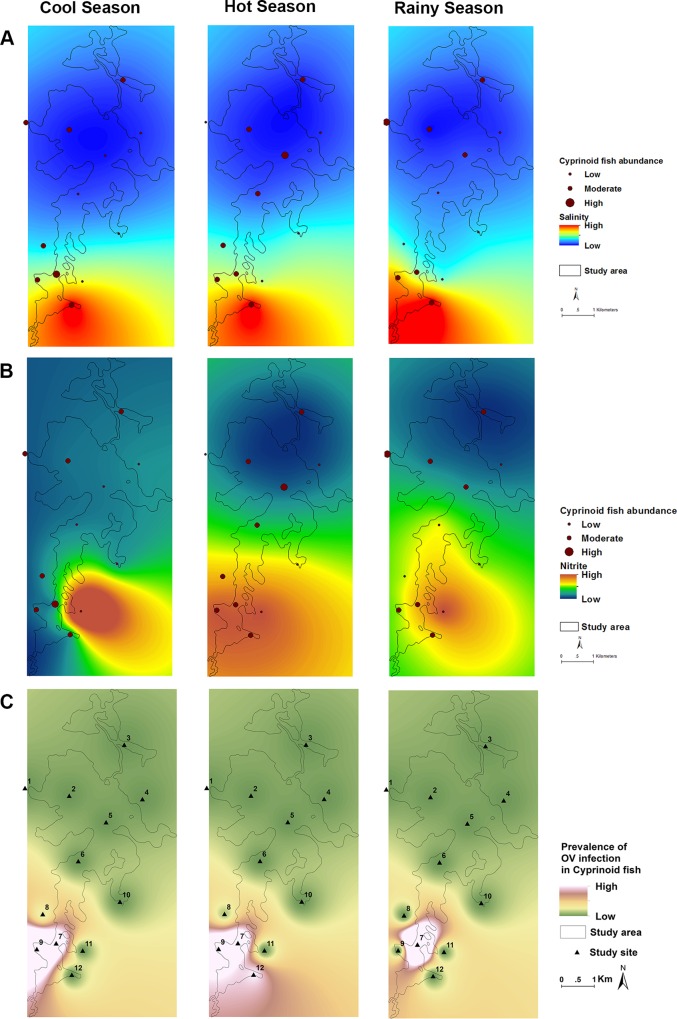
Kriging geographic analysis of the abundance of cyprinid fish in relation to (A) salinity, (B) nitrite. Panel (C) shows the prevalence of Ov infection in cyprinid fish. Data for the rainy season, cool season and hot season is shown.